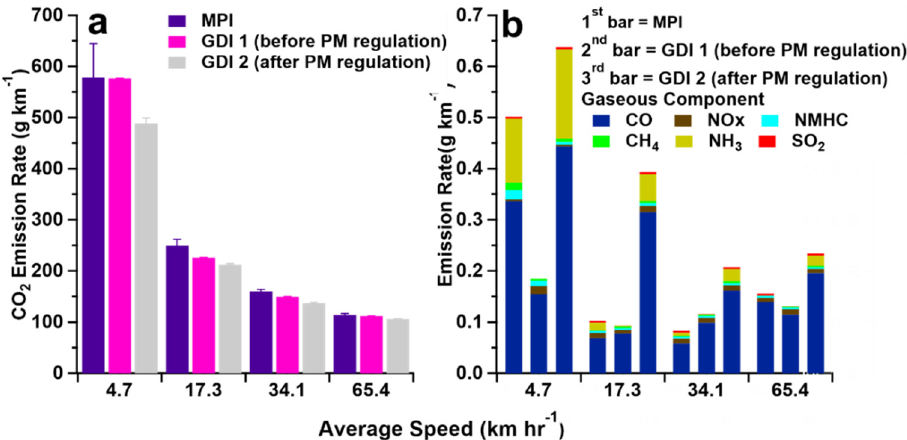
Figure Figure 4. Results obtained from chassis dynamometer tests performed on gasoline vehicles incorporating different combustion technologies and operating at different speeds—( a ) Trends concerning CO 2 -emission rate; ( b ) Trends concerning emission rates of CO, NOx, non-methane hydrocarbons (NMHC), CH 4 , NH 3 , and SO 2